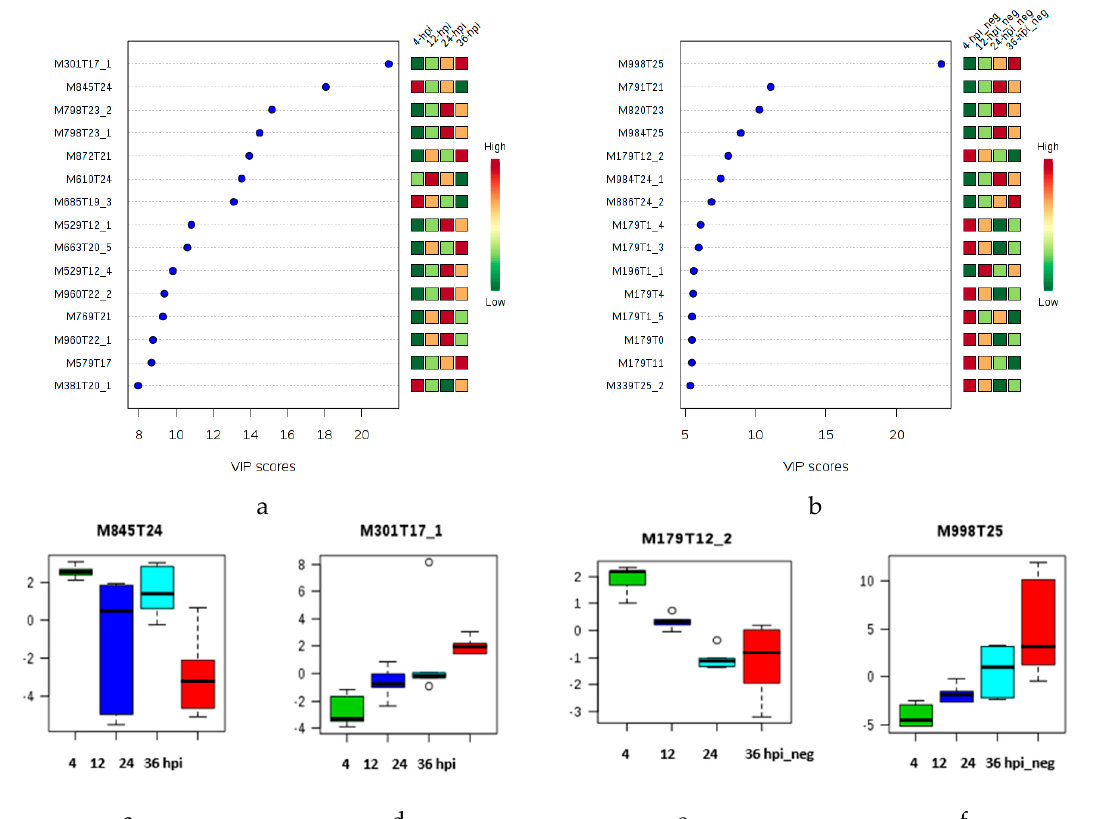
Figure 2. VIP score-plots derived from the PLS-DA analysis, displaying the discriminant features at the early asymptomatic infection stage (cluster I: 4, 12, 24 and 36 hpi): ( a ) LC-ESI (+)-MS and ( b ) LC-ESI ( − )-MS. Coding of M and T after the number respectively indicates nominal mass and retention time of each feature. ( c – f ). Box plots from s-plot of the molecular features M845T24 ( m / z 845.4816), M301T17 ( m / z 301.1379), M179T12 ( m / z 178.9792) and M998T24 ( m / z 997.5185), respectively. In the box plot, Y axis represents intensity of the metabolites as quartile for each sample group related to all data set. The range of the vertical scale is from the minimum to the maximum value of the selected group, or, to the highest or lowest of the displayed reference points, median, and 95% confidence interval of the mean. Coding 4-hpi means positive ionization mode analysis of the samples collected at four hours post infection. Coding 4-hpi_neg means negative ionization mode analysis of the samples collected at four hours post infection. Coding C and C_neg indicates the analysis of the controls in positive and negative ionization modes, respectively.